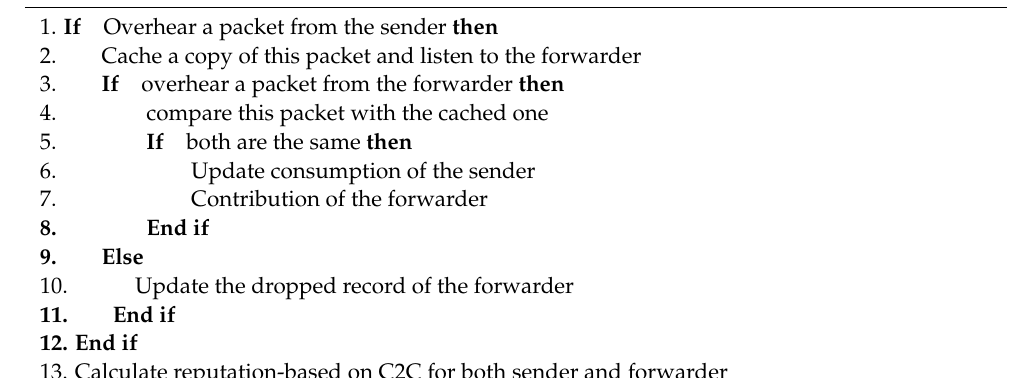
Algorithm 3. Reputation calculation for sender node ( S ) and intermediate node ( F ) by neighbor node